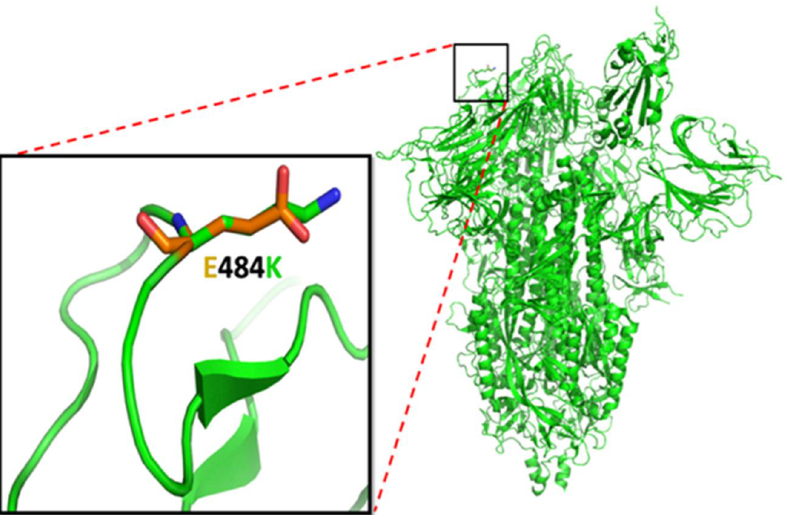
Figure 6. The E484K mutation: the structure in green represents the spike glycoprotein. The magnified black box represents the surface-exposed E484K mutation. The glutamic acid and mutated lysine residue were superimposed on the same region (shown in the box). The orange color denotes the negative charge of glutamic acid, and the green color depicts the positive charge of lysine. The mutated lysine changes the surface property because of its positive charge, and length of side chain compared with glutamic acid.